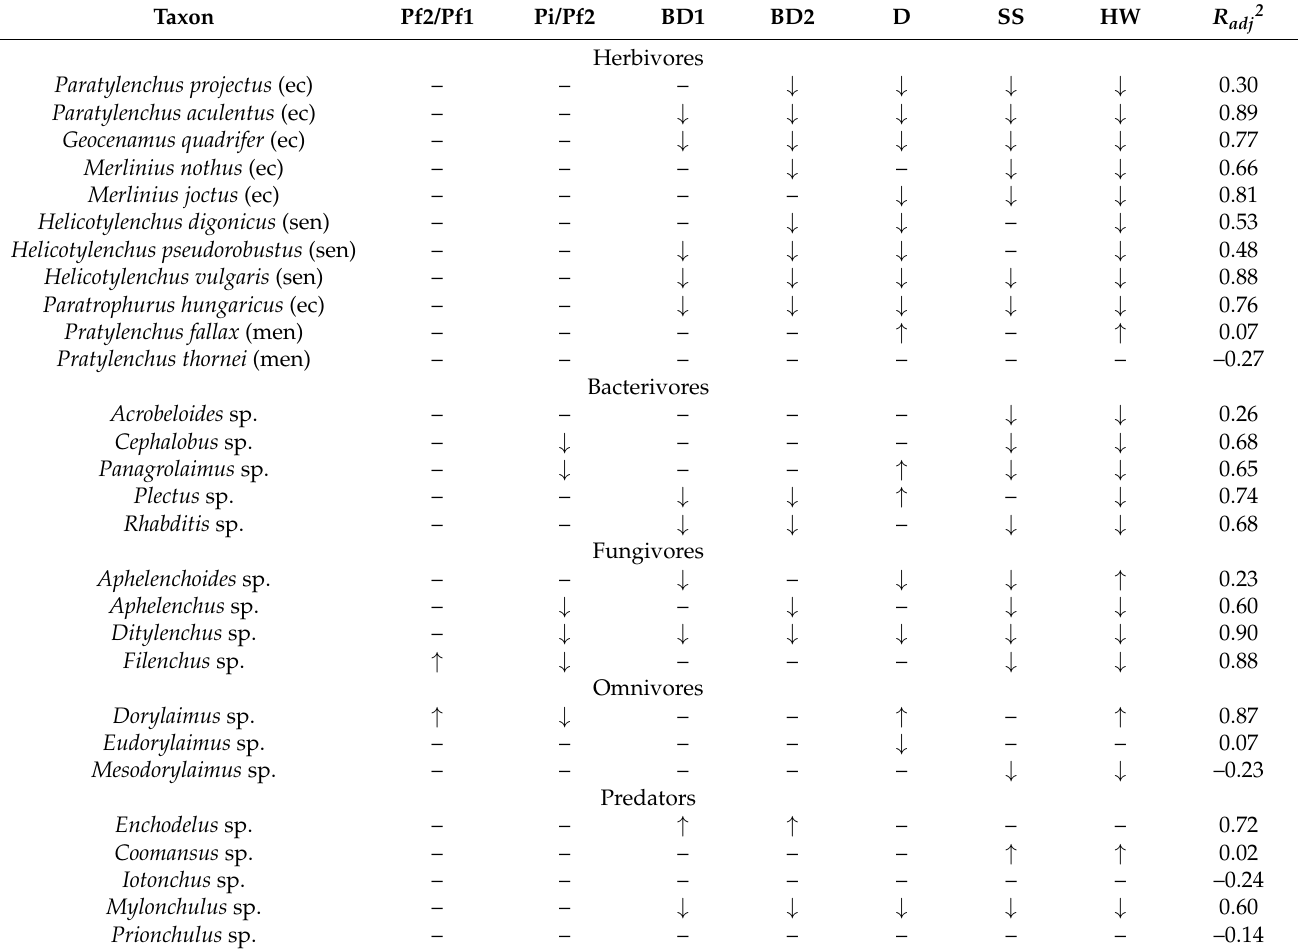
Table 5. Response of given nematode taxa abundance to the effect of the sampling time from multivariate